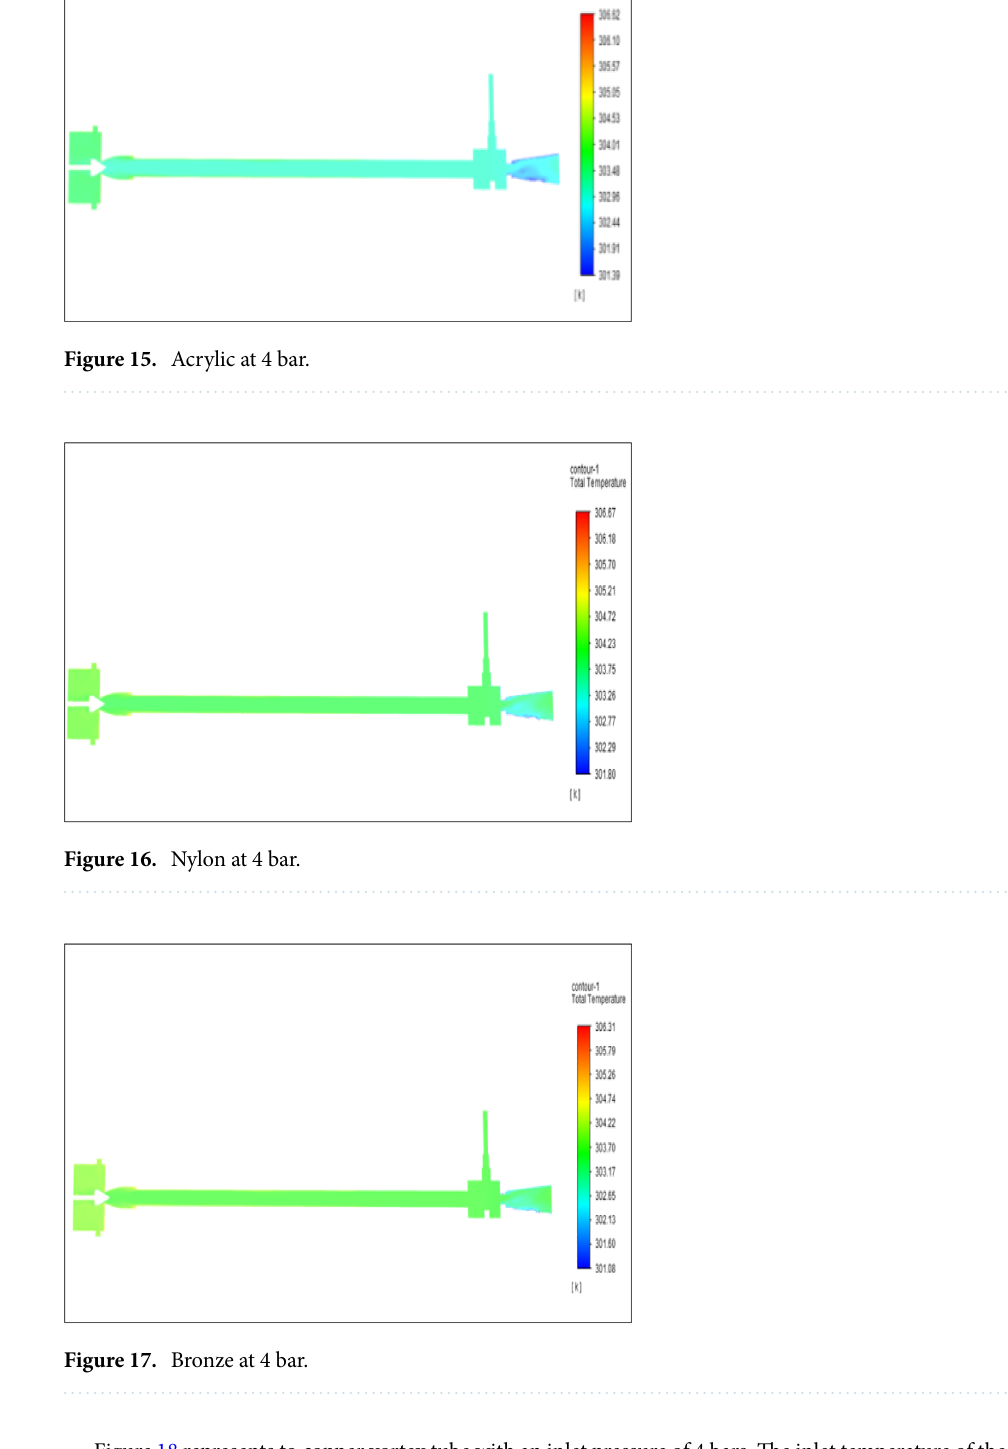
Figure 18 represents to copper vortex tube with an inlet pressure of 4 bars. The inlet temperature of the VT is 303 K. The hot air temperature was obtained at the hot end as 306.79 K and at the cold end side obtained a value of 301.12 K. The maximum temperature difference was found to be 5.67 K. Pressure at 6 bar. Figure 19 related to stainless steel vortex tube with an inlet pressure of 6 bars. The inlet temperature of the VT is 303 K. The hot air temperature was obtained at hot end as 307.89 K and at the cold end side obtained a value of 300.11 K. The maximum temperature difference was noticed as 7.78 K.